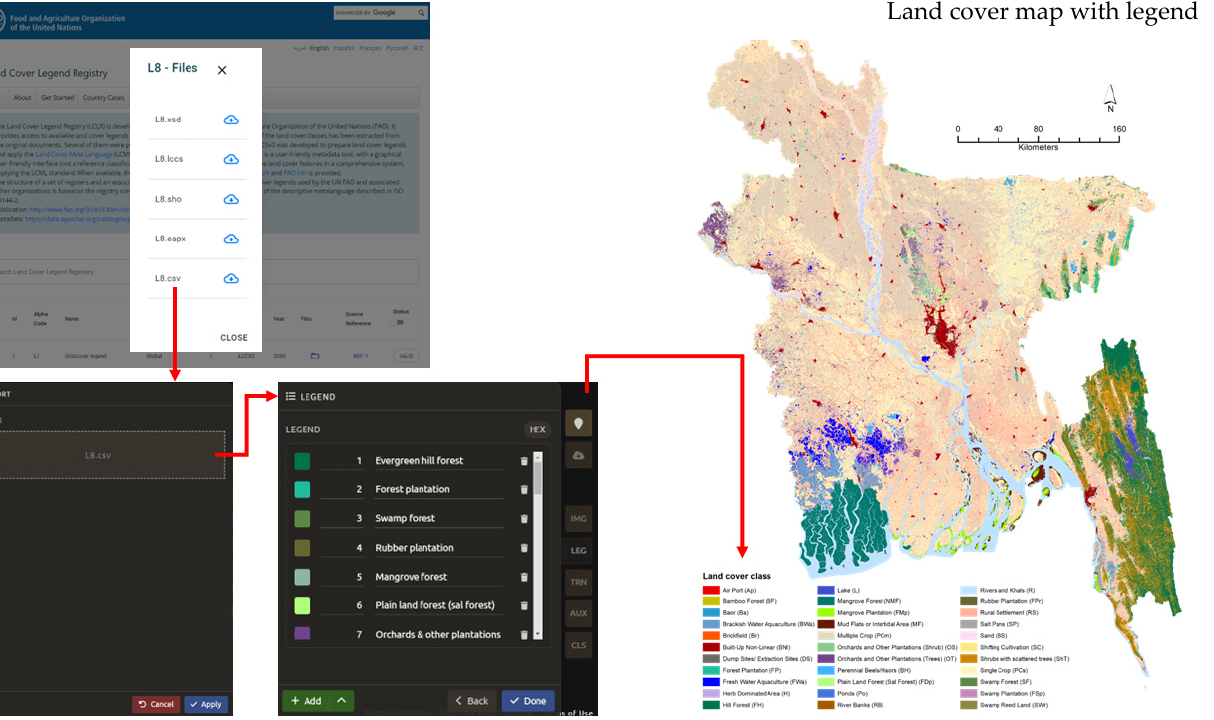
Land cover map with legend